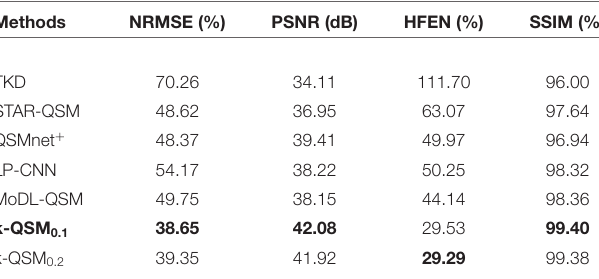
TABLE 1 | Comparison of quantitative performance metrics on results from different quantitative susceptibility mapping (QSM) reconstruction methods referenced to calculation of susceptibility through multiple orientation sampling (COSMOS) on data from the FM Kirby Research Center.